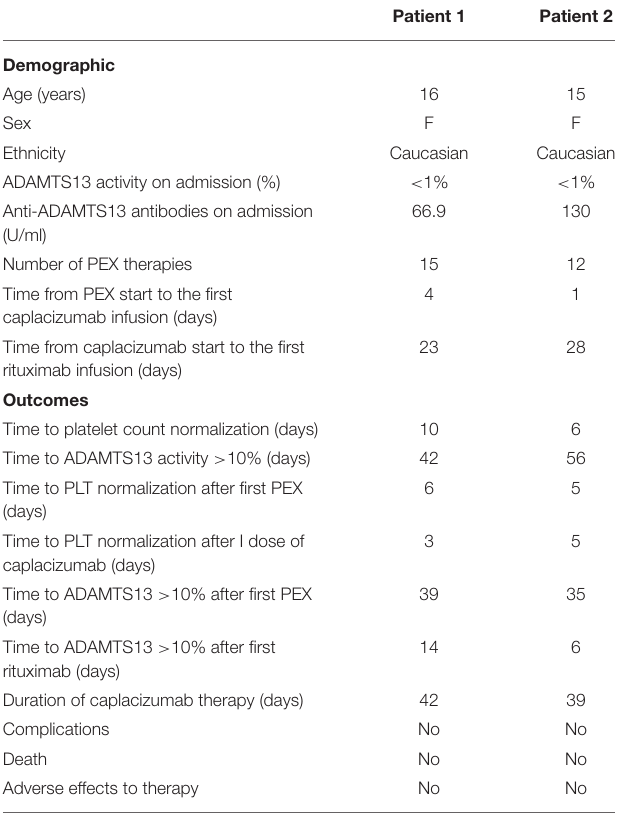
TABLE 1 | Demographic and outcome factors in our two